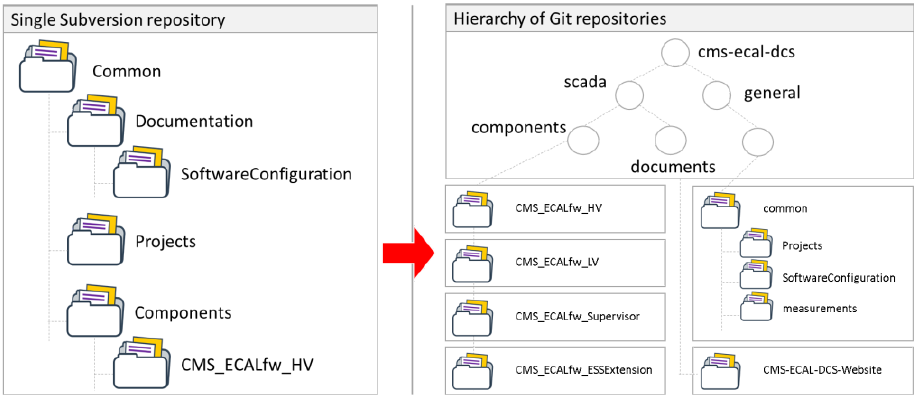
Fig. 1. Migration from a single Subversion code repository to a hierarchy of Git